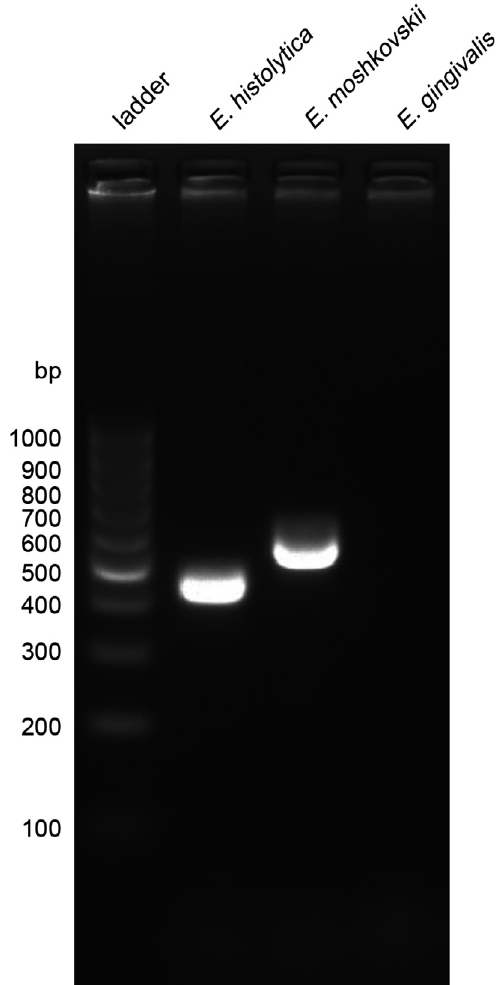
Figure 3. Entamoeba gingivalis is not detected by primers specific for other species of the Entamoeba genus. Agarose gel-resolved products from nested PCR using 1 ng E. moshkovskii , 1 ng E. histolytica and 125 ng E. gingivalis patient #0 DNA. Amplifi- cation was not obtained in control without matrix (not presented) and E. gingivalis